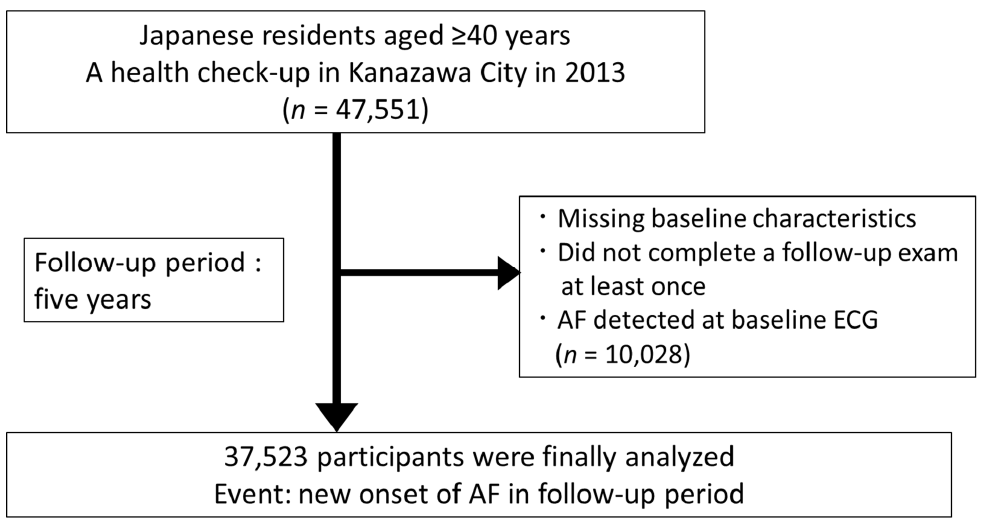
Figure 1. Study flow chart. Eligible participants were Japanese residents aged ≥ 40 years who had undergone 12-lead electrocardiogram (ECG) during a Japanese-specific health checkup in Kanazawa City in 2013 ( n = 47,551). We excluded participants with missing baseline characteristics, those who did not complete a follow-up examination at least once during the 5-year follow-up period, those with AF detected at the baseline ECG, and those without adequate follow-up ( n = 10,028). An event was defined as a new onset of AF diagnosed by automatic analysis of ECG based on the Minnesota code (8-3) during the follow-up